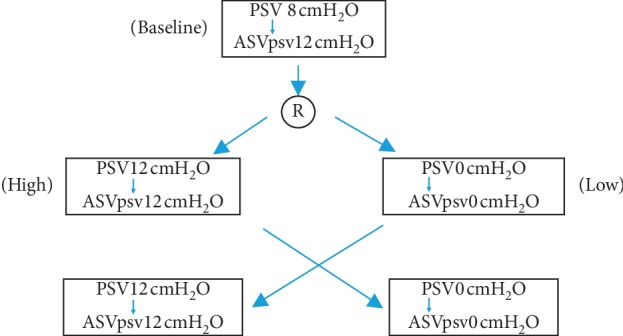
Study design. R indicates randomized.